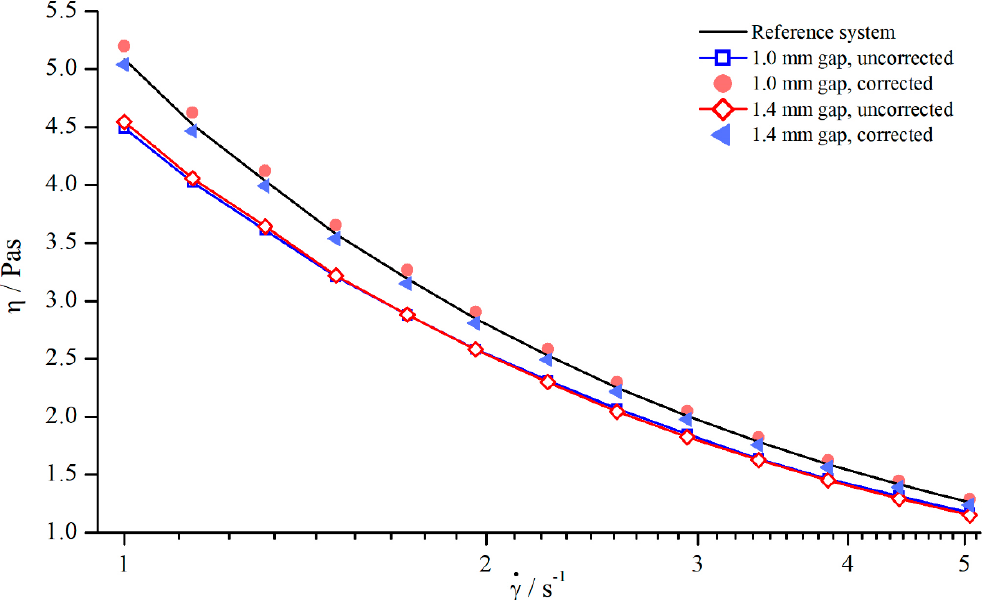
Figure 16. Correction of viscosity values obtained for columns (system 6) at 𝐻 = 1.4 mm and 𝐻 = 1.0 mm .